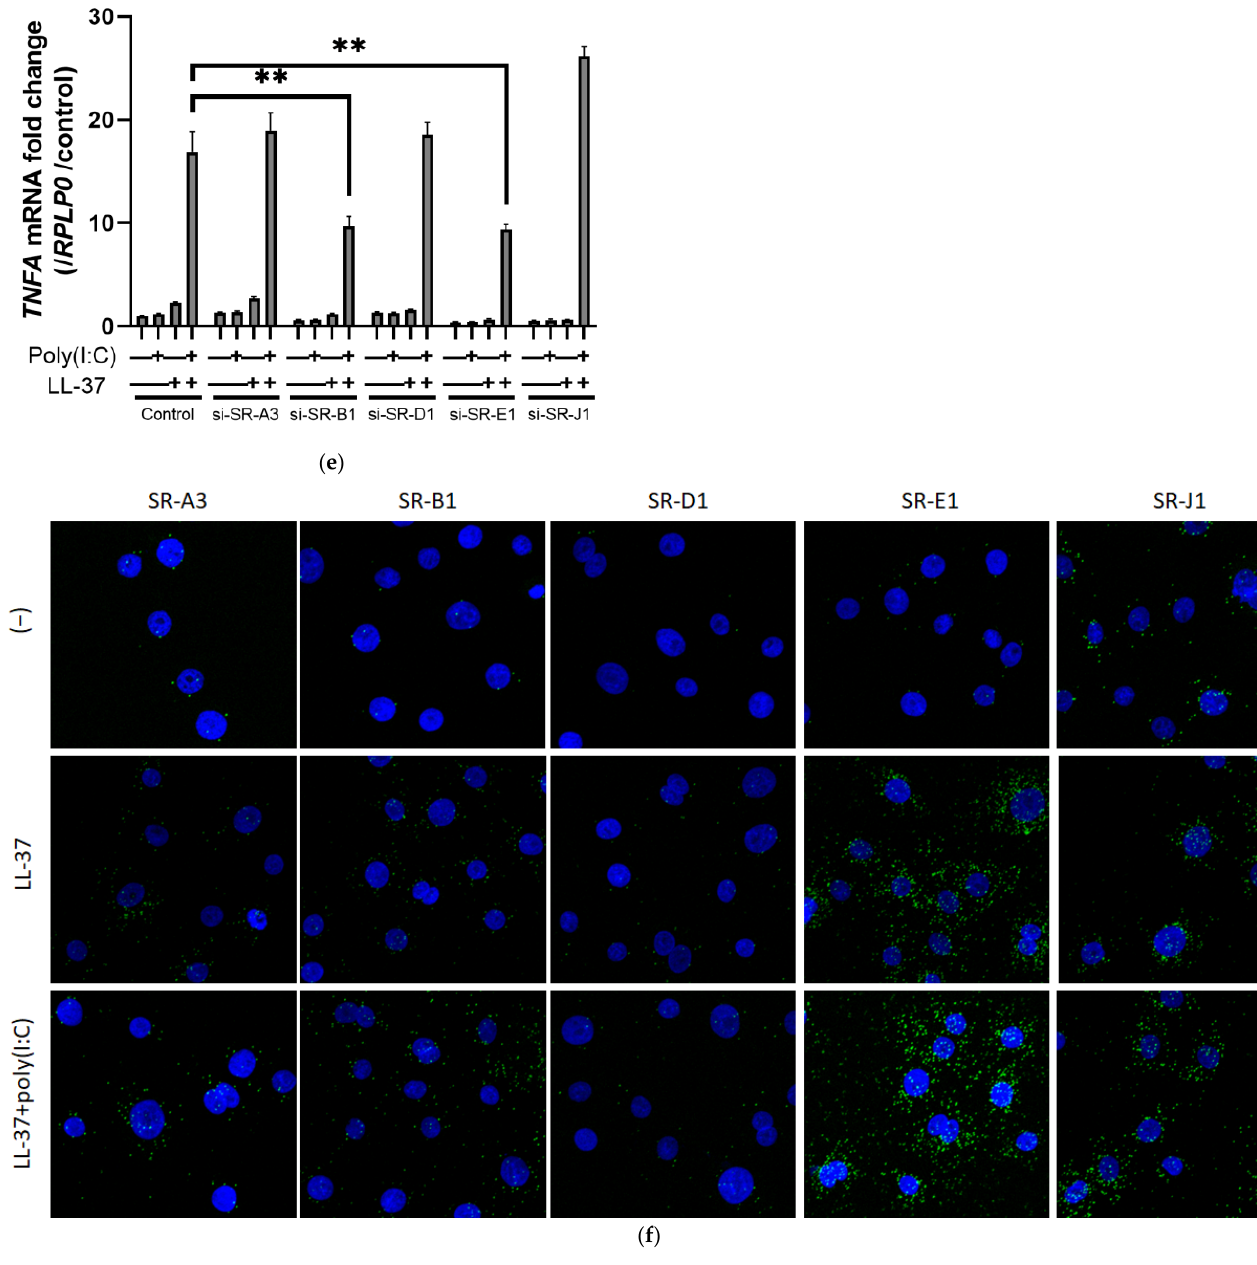
Figure 3. Stimulation by LL-37 alone or in combination with poly(I:C) in NHEKs is mediated by scavenger receptors. SCARA3 (SR-A3), SCARB1 (SR-B1), CD68 (SR-D1), OLR1 (SR-E1), AGER (SR-J1), and non-targeting pool siRNAs were transfected into NHEKs, and the cells were stimulated with LL-37, poly(I:C) or LL-37+poly(I:C) 2 days later. After 6 h of incubation, mRNA induction was evaluated by RT-PCR. The inductions of ( a ) PTGS2 , ( b ) VEGFA , ( c ) CXCL10, ( d ) IFNB1, and ( e ) TNFA are shown, respectively. ( f ) PLA was performed for various scavenger receptors and LL-37. LL-37 was added to NHEKs, 10 min later poly(I:C) was added, and the cells were incubated at 4 °C for 1 h. Using antibodies against various scavenger receptors and LL-37, the proximity of each scavenger receptor and LL-37 was detected by fluorescence-based PLA as green fluorescent spots. Nuclei (blue) were counterstained with DAPI. Data are means ± SEM of three biological replicates. ** p ≤ 0.01, **** p ≤ 0.0001 by two-way ANOVA with Bonferroni’s post hoc test. See also Figures S3 and S4.